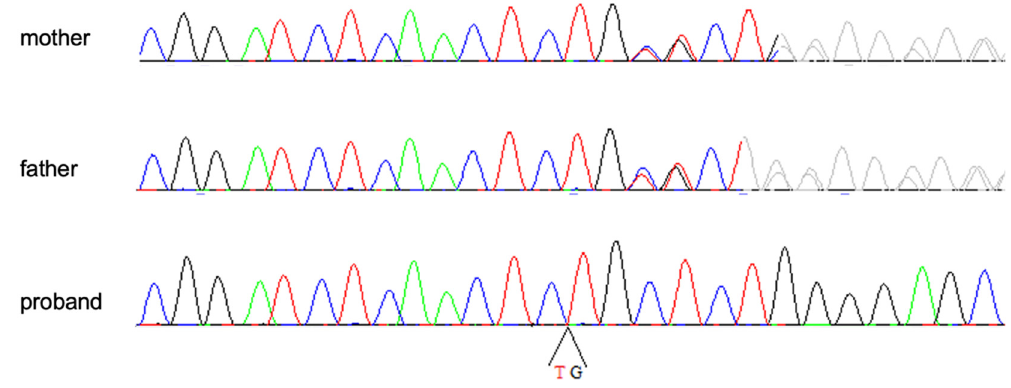
Figure 4. Electropherograms of the homozygous patient and his heterozygous parents. The DNA variants resulting from NGS data analysis and filtering , as well as their ACMG/AMP classification, are reported in Supplementary Table S1 .